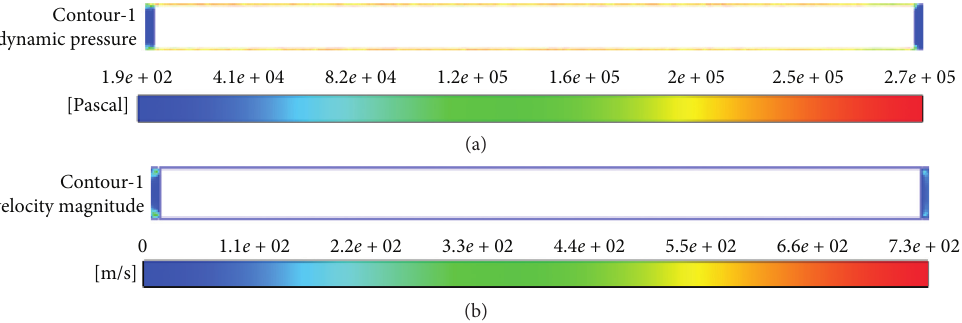
Table 2 represents the annulus throttling pressure drop for